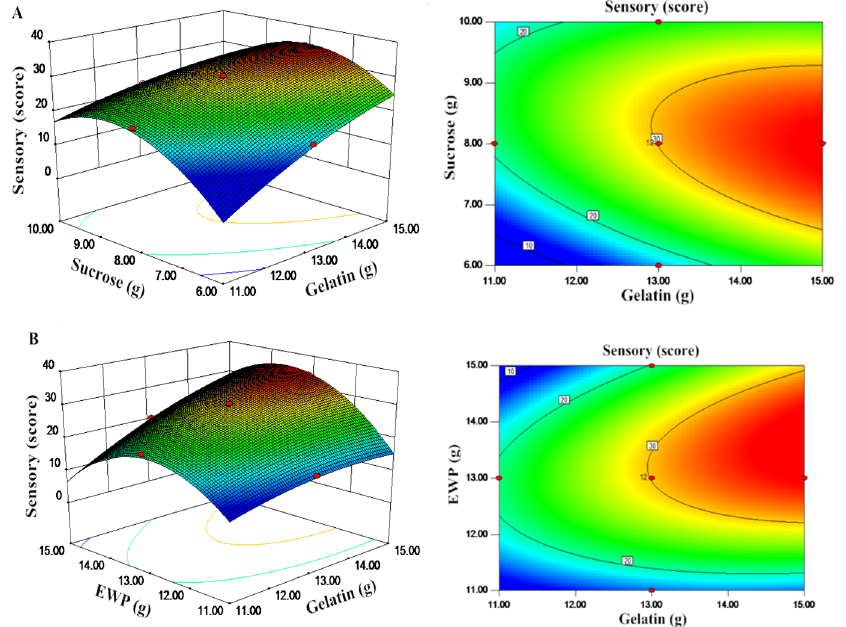
Figure 3. ( A ) Interactive effects of the amounts of the added gelatin and sucrose on the sensory score; ( B ) the interactive effects of the amount of the added gelatin and EWP on the sensory score.